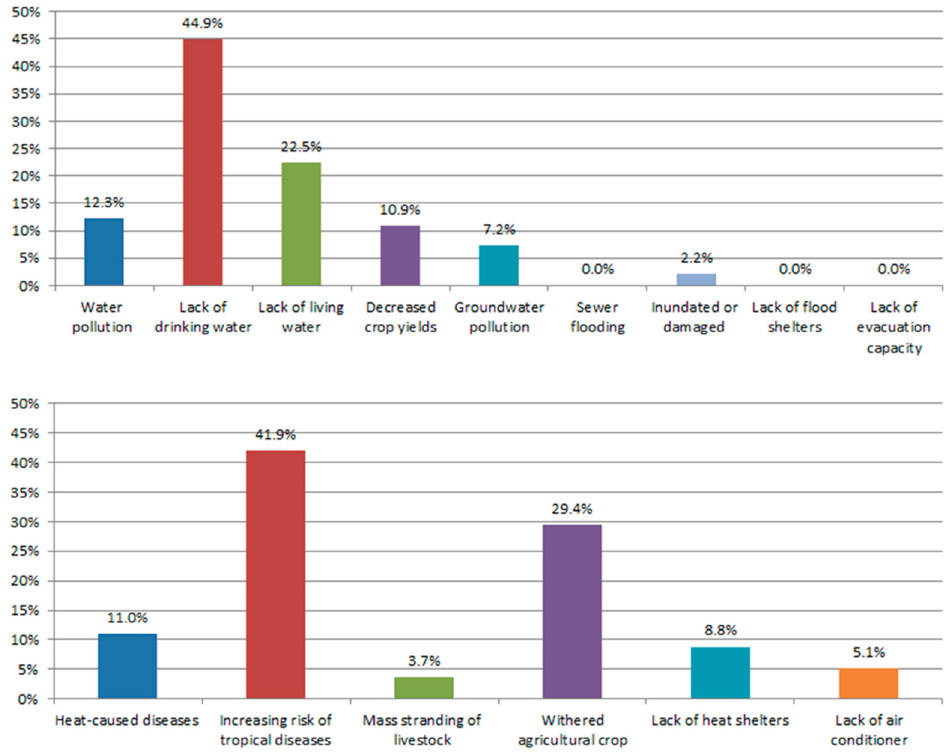
Figure 5. Most a ff ected climate change risks in terms of water ( top ) and heat ( bottom ) as assessed by stakeholders.